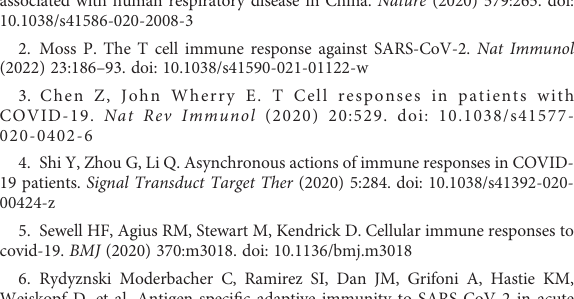
Two distinct Hepatitis C virus epitopes and their pMHCs electrostatic patterns. The variation (detached in red) between the wild-type peptide sequence (CVNGVCWTV) with its variant peptide (TVGDVMWTV) leads to divergent charge distribution at the indicated pMHC surface area (pink square). This variant peptide, from HCV genotype 3, aborts the cellular response in lymphocytes that recognizes the WT peptide. The electrostatic potential distribution is colored as follows: from -5 (electronegative in red) to +5 (positive in blue), passing through 0 (neutral in